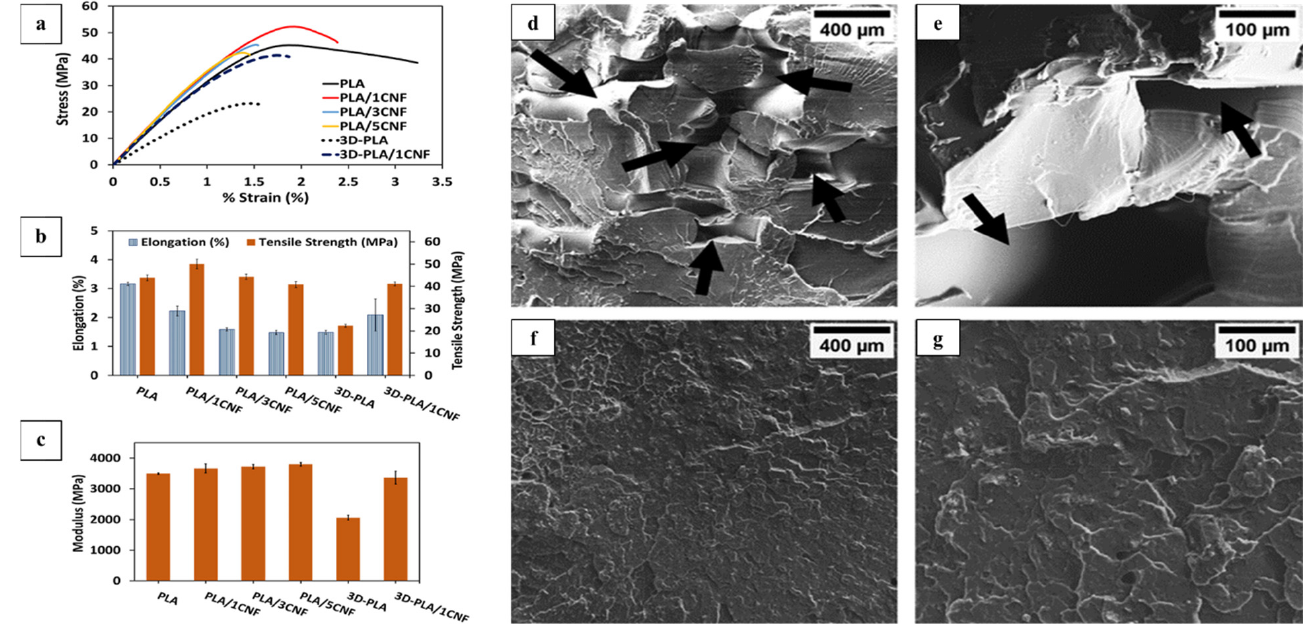
Figure 9. Tensile stress–strain curve of compression-molded and 3D-printed PLA and PLA/CNF composites ( a ) and histograms of mechanical properties of the samples ( b , c ). Scanning electron microscopy micrographs (×150 and ×600) of the tensile fracture surface of 3D-printed PLA ( d , e ) and 3D-PLA/1% cellulose nanofiber composites ( f , g ), used with permission from ref. [59].